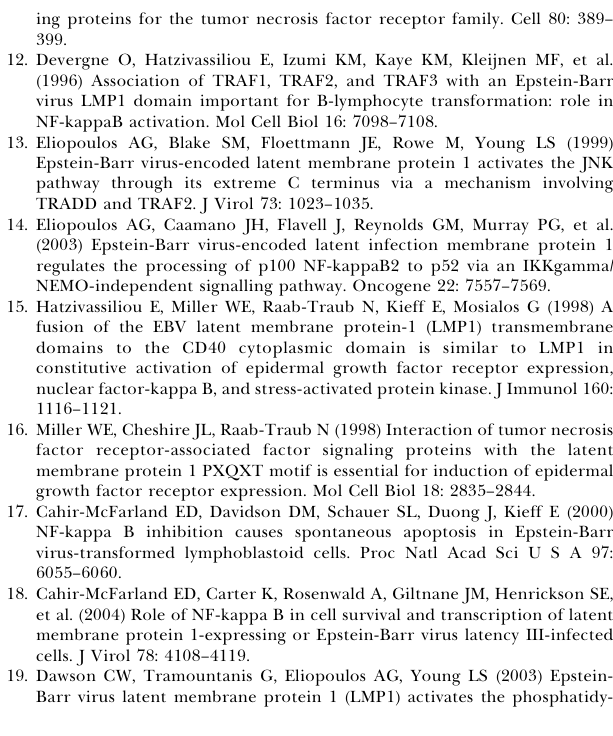
Figure S1. Lymphomas Are Clonal by j Light Chain